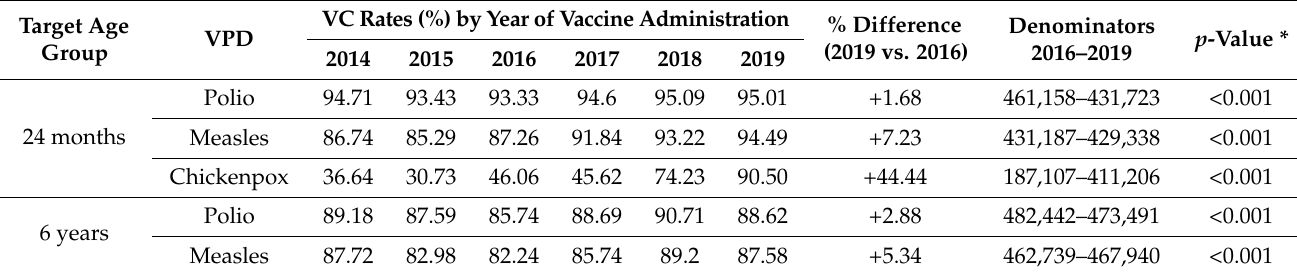
Table 1. Vaccination coverage (VC) rates (%) registered for mandatory vaccinations, plus chickenpox at 24 months and 6 years of age, stratified by vaccine type and year of administration, along with the percentage differences between 2019 and 2016 rate. Italy, 2014 to 2019.